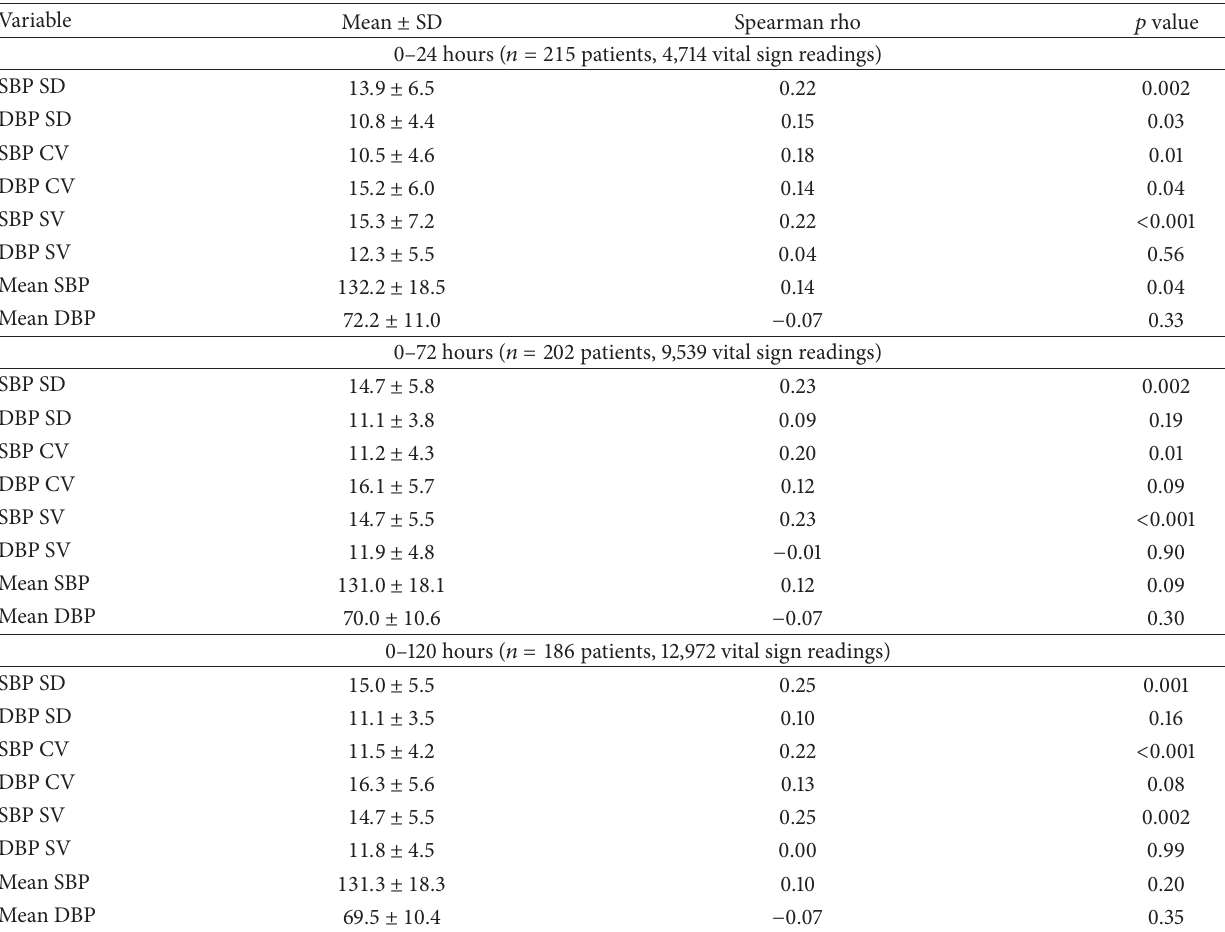
Table 2: Spearman rank correlation coefficient for blood pressure indices and mRS and mean ± SD values. Variable